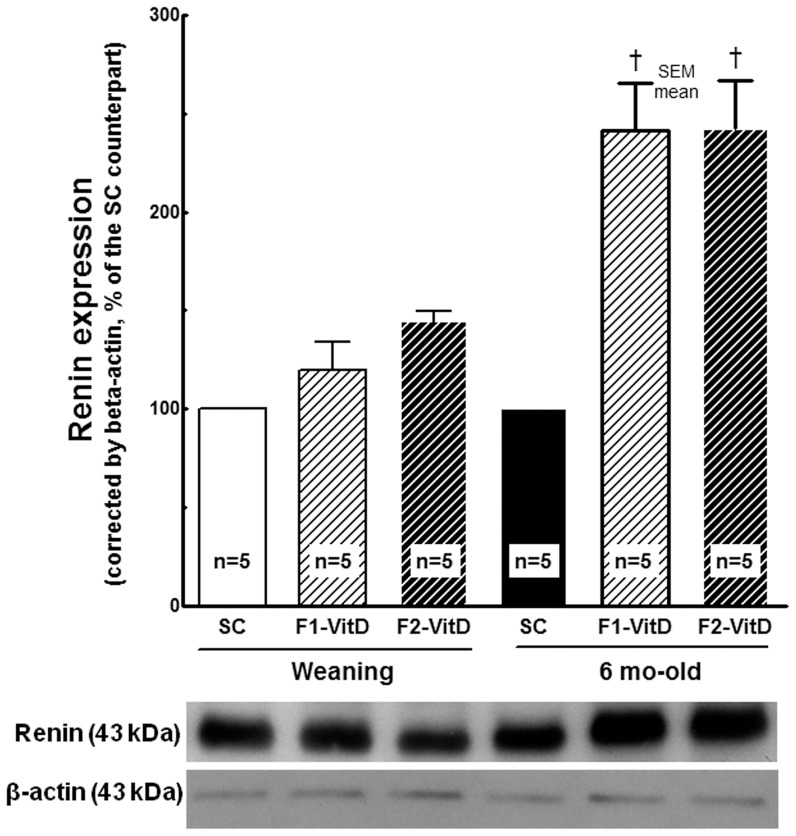
Western blotting analysis of renal tissue at weaning and 6 months of age for renin expression.Average values were measured and equal protein loading was confirmed by probing blots with beta-actin antibody and is expressed as a percentage of the SC counterpart. Data are reported as means ± SEM; P<0.05, one-way ANOVA and post-hoc of Tukey's test: † compared to SC counterpart; ‡ compared to F1 generation.